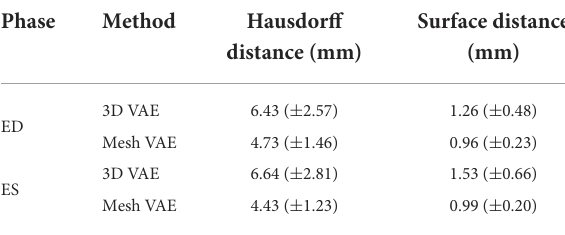
TABLE 1 Reconstruction results of the mesh VAE and the 3D VAE on the test